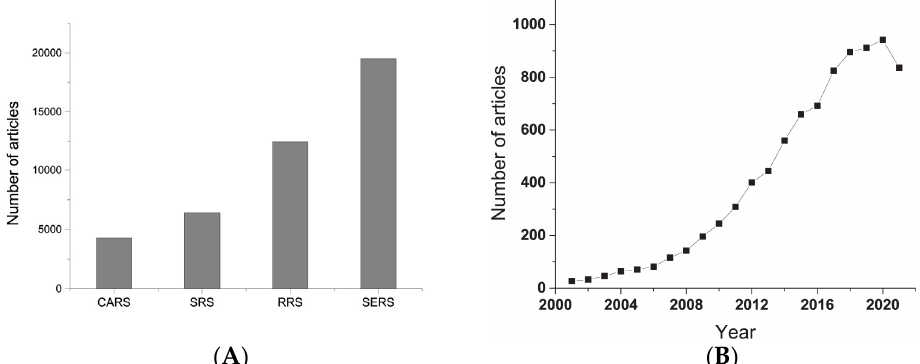
Figure 2. ( A ) The number of articles published over the past two decades (January 2001–October 2021) according to the Web of Science (WoS) database found using the following keywords: (a) coherent Raman scattering; (b) stimulated Raman scattering; (c) resonance Raman scattering; (d) surface- enhanced Raman scattering. ( B ) Dynamics of published articles on the SERS over the past two decades (January 2001–October 2021) according to the WoS